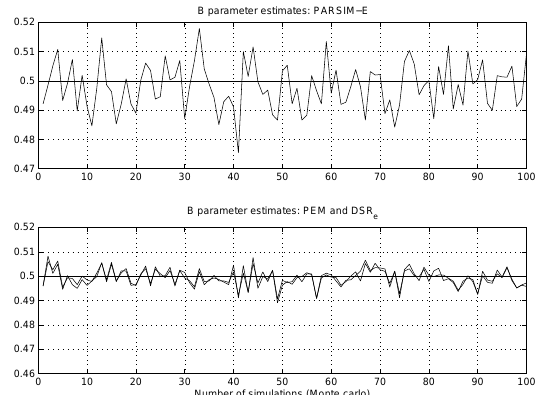
Figure 2: B parameter estimates of the closed loop sys- tem in Example 7.1 with parameters as in Case 1. In Figs. 1 and 2 the PARSIM-E algorithm fails to give acceptable estimates compared to the corresponding DSR e and PEM estimates.